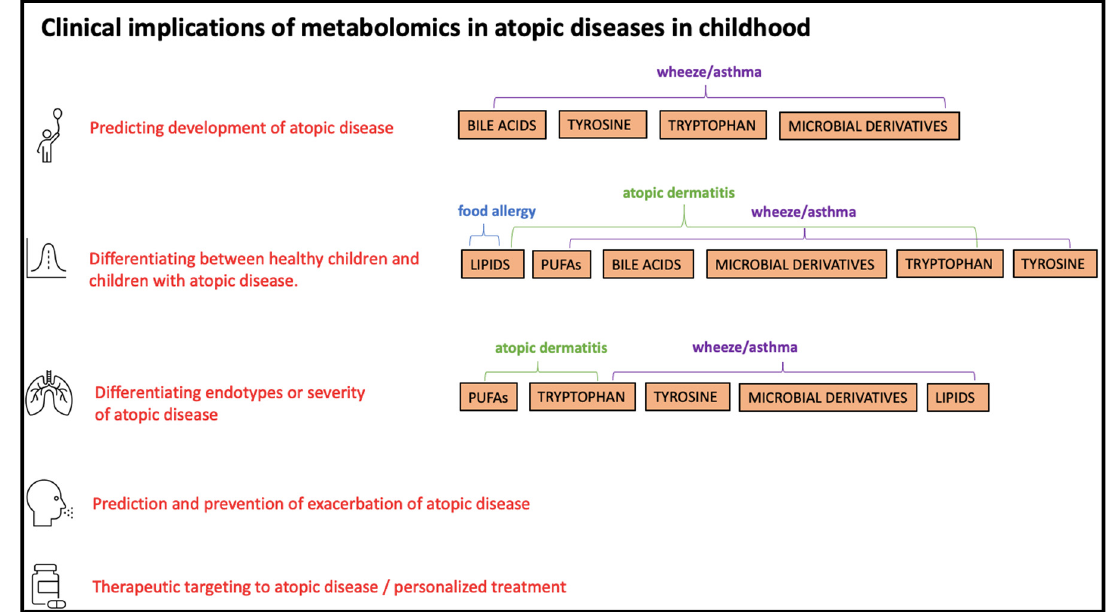
Figure 3. Clinical implications of metabolomics in atopic diseases related to pathways of interest in at least one of the included studies.